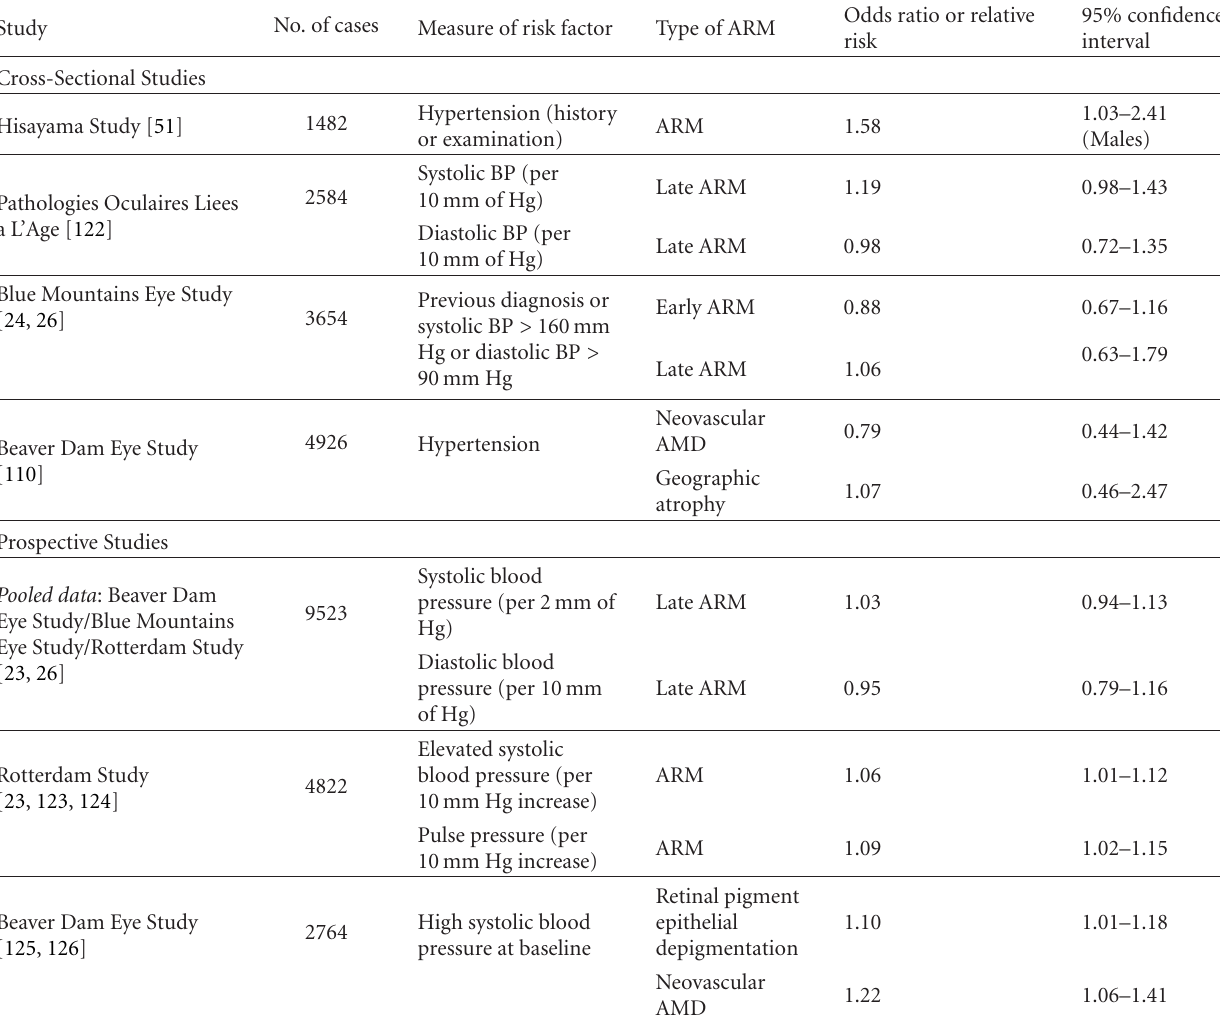
Table 4: Studies investigating the relationship between hypertension and risk for